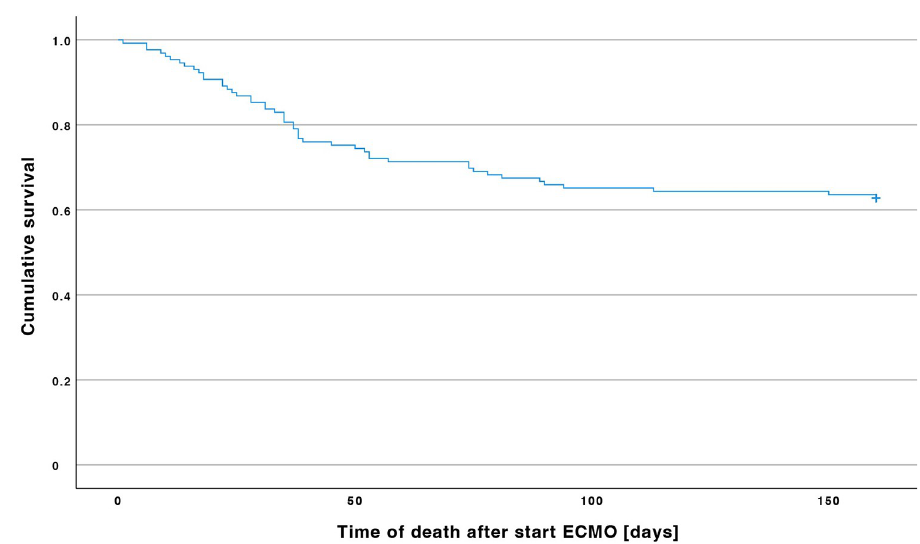
Fig 3. Kaplan-Meier estimator. Out of 129 patients treated with veno-venous extracorporeal membrane oxygenation (VV ECMO), 48 (37.2%) patients had died in the intensive care unit. In the group of non-survivors, the last patient had died 134 days after the start of VV